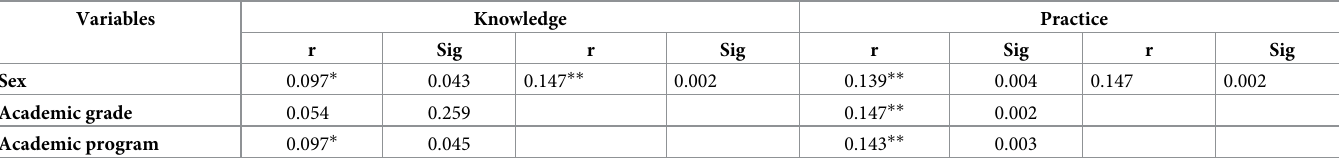
Table 5. Correlation between facemask disposal knowledge and